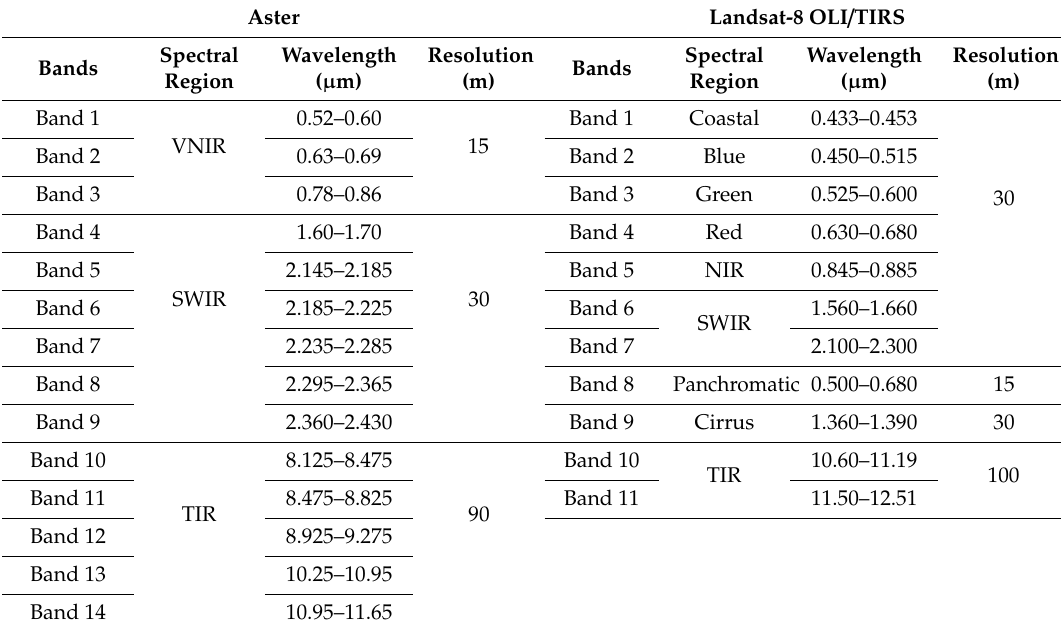
Table 1. Summarized characteristics of the ASTER and Landsat-8 OLI / TIRS